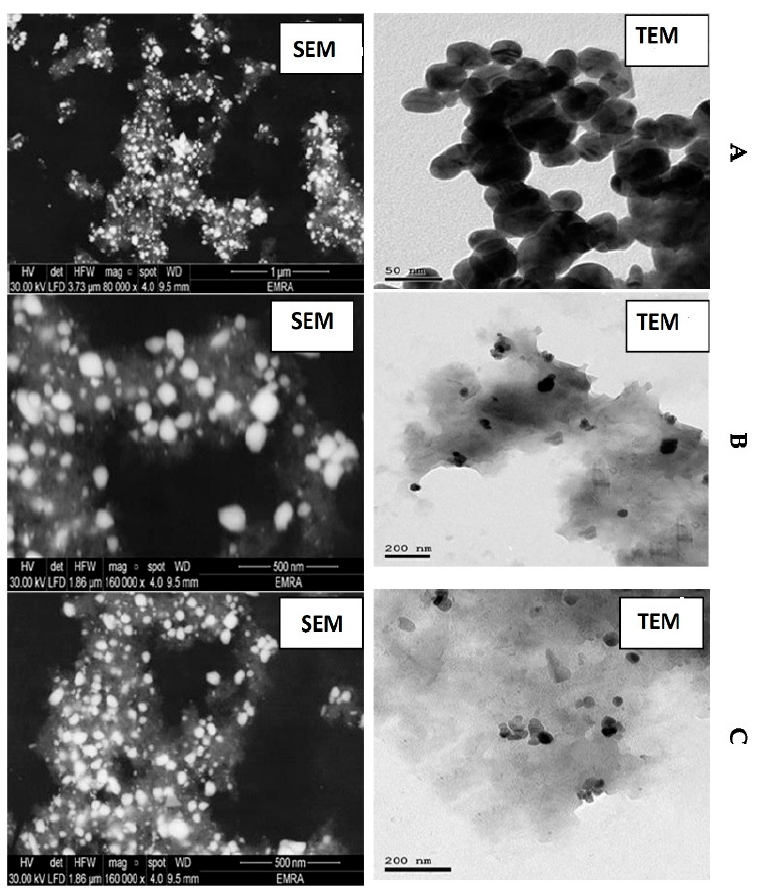
Figure 5. Transmission Electron Microscopy (TEM) and Scanning Electron Microscopy (SEM) images of ( A ) silver nanoparticles (AgNPs), ( B ) silver-fenugreek seed protein nanocomposite (Ag-FNP), and ( C ) silver-mung bean seed protein nanocomposite (Ag-MNP). The AFM images consolidated the results of electron microscopic examinations wherein both FNP and Ag-FNP showed subtriangular shapes. However, both MNP and Ag-MNP showed rectangular shapes (Figure 6).